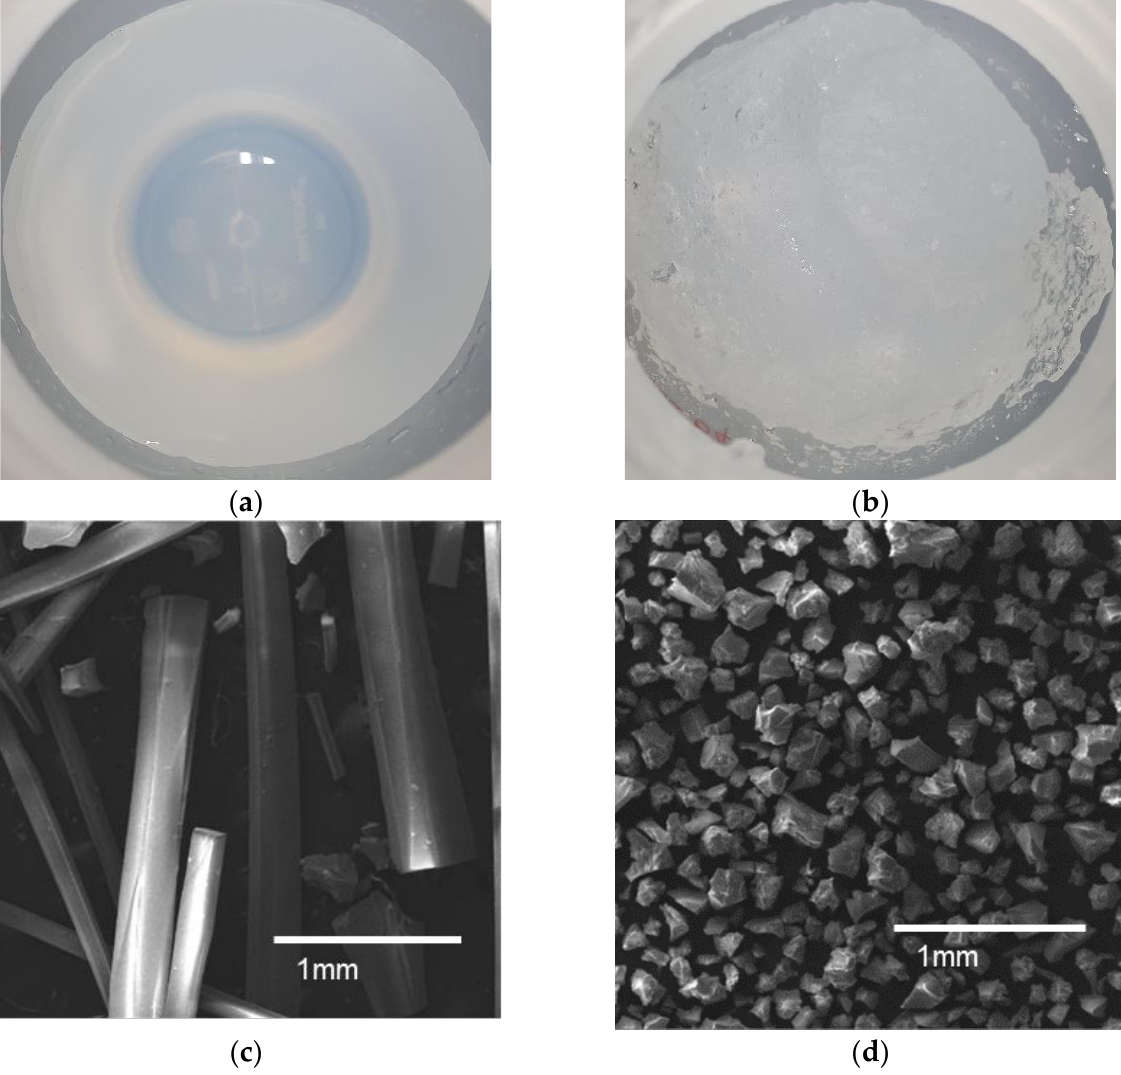
Figure 3. Effect of gel-pulverizing process on morphology of as-synthesized quartz powder. ( a,b ) Photographs of hydrogels with and without pulverizing process, respectively. ( c,d ) SEM images of quartz powder samples synthesized with and without pulverizing process, respectively.